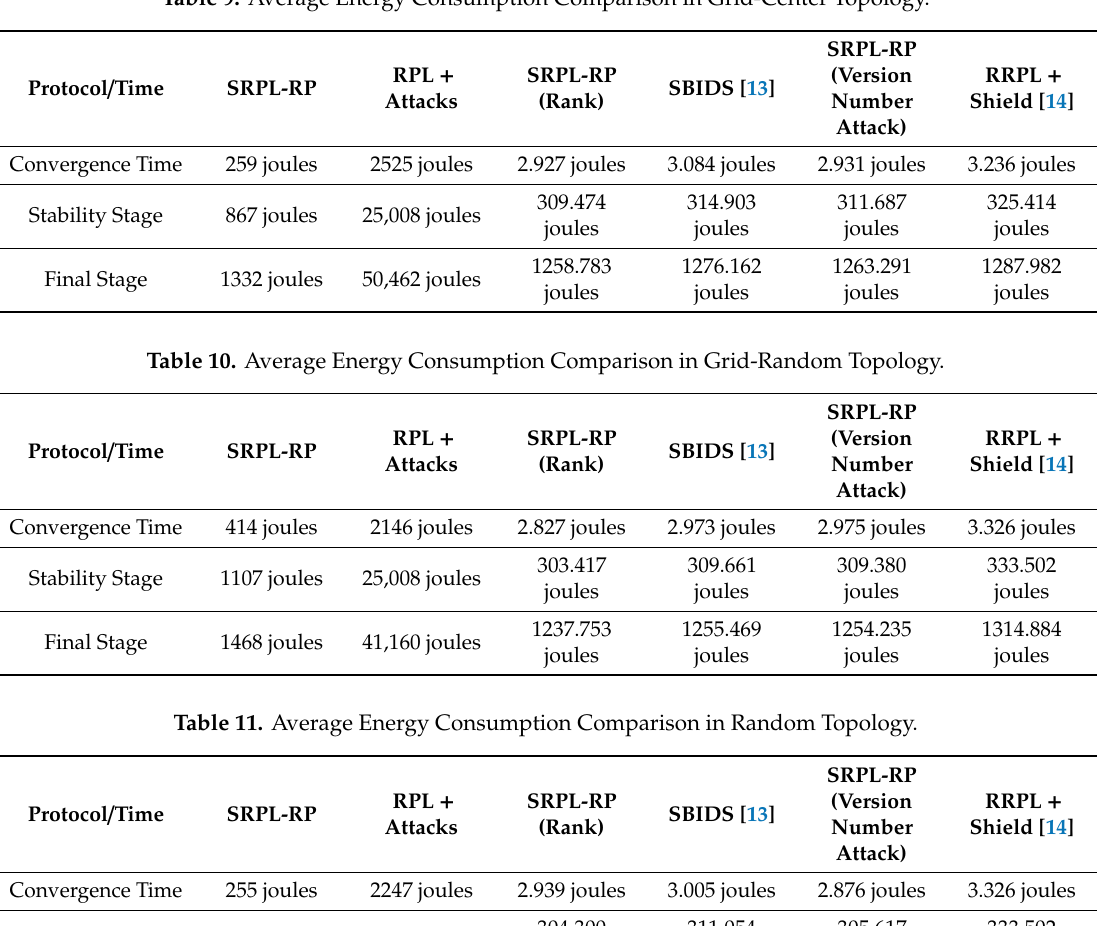
Table 9. Average Energy Consumption Comparison in Grid-Center Topology.